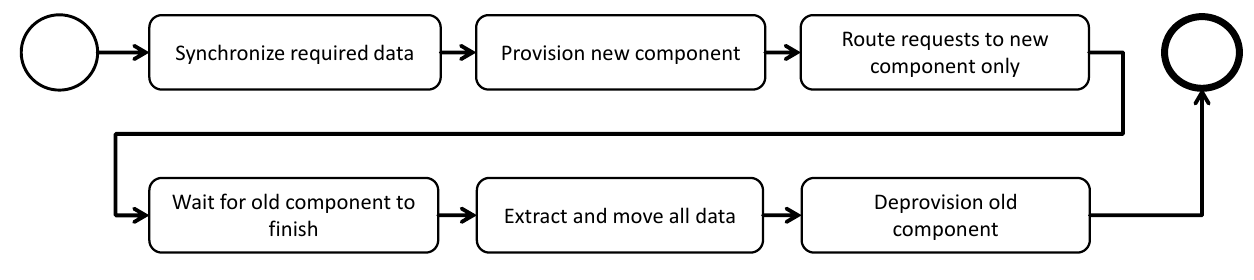
Figure 14. Abstract Management Flow of the Move/Update without Downtime